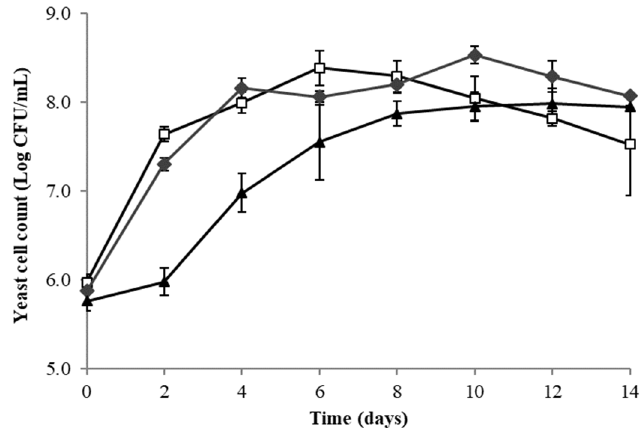
Figure 1. Evolution of yeast cell counts during 14-day fermentation of red dragon fruit juice by T. delbrueckii Biodiva ( ♦ ), L. thermotolerans Concerto ( □ ) and S. cerevisiae EC-1118 ( ▲ ). All three yeast strains exhibited similar evolution patterns in terms of the changes in